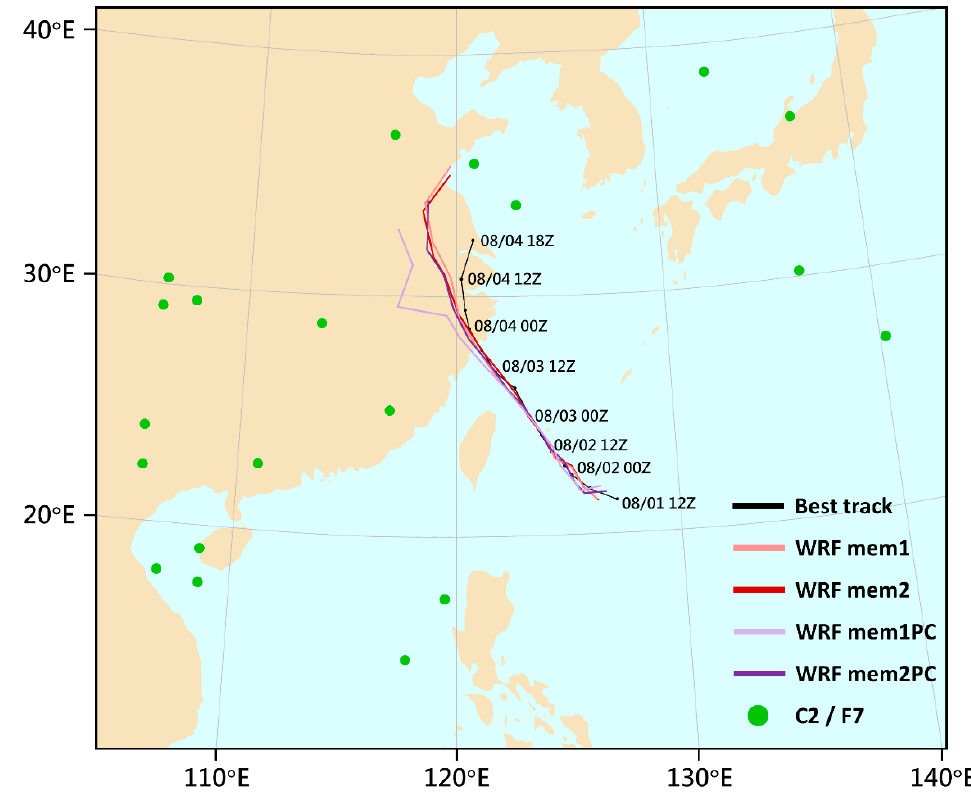
Figure 12. The 78-h track forecasts for typhoon Hagupit initialized at 12:00 UTC 1 August 2020, for WRF Members 1 (pink curve), 2 (red curve), 1PC (light purple curve), and 2PC (dark purple curve). The black curve denotes the best track at 6-h intervals from CWB. The green dots denote the COSMIC-2/FORMOSAT-7 RO observations assimilated by WRF Members 2 and 2PC. Table 1. The total track error differences (km) of Member 2 minus Member 2PC and Member 1PC minus Member 2PC, where positive values represent the superiority of Member 2PC.